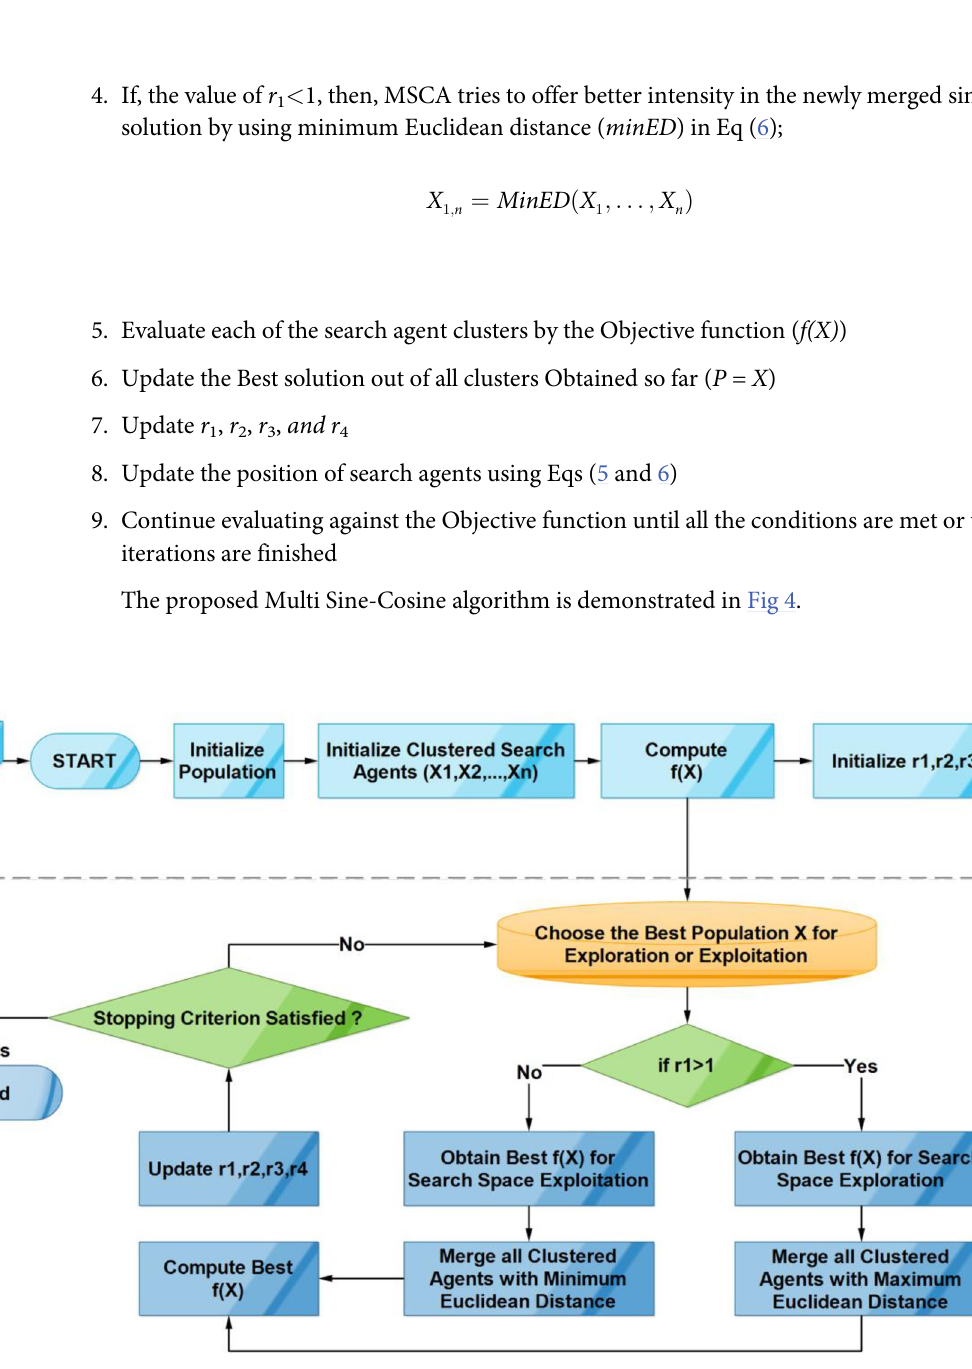
Fig 4. The workflow of the proposed MSCA algorithm.